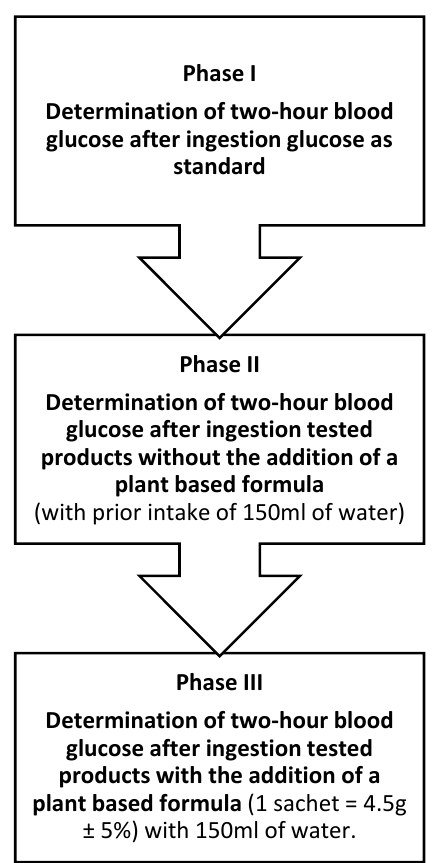
Figure 1. Study design.